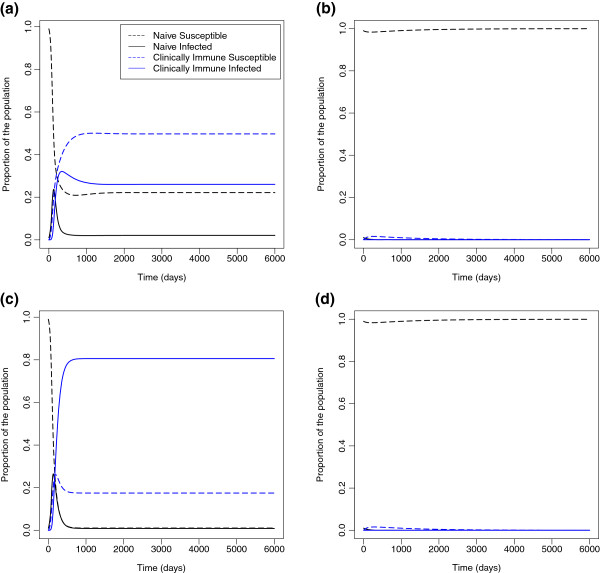
Simulation of malaria transmission in a naïve population. We simulated malaria transmission in a population with 95% naïve susceptible and 5% naïve infectious individuals (SN=0.95,IN=0.05,SC=0,IC=0,N=1, α=0.001, γNN=0.02, γNC=0.02, γC=0.005, μ=0.000039, and σ=0.7) under two assumptions of ρ. Panels a and b show ρ=0.5 and panels c and d show ρ=3.5(a)RNN=2>1>RCC=1. (b)1>RNN=0.75>RCC>0.375. (c)RCC=7>RNN=2>1. (d)RCC=2.625>1>RNN=0.75.